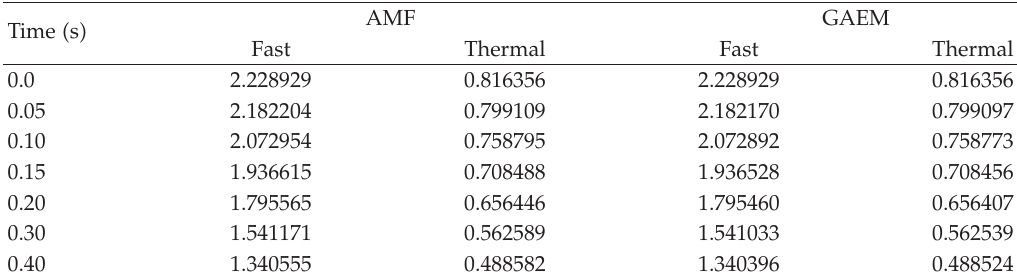
Table 5: Neutron flux at the center point of three dimensional homogeneous reactor with a negative ramp